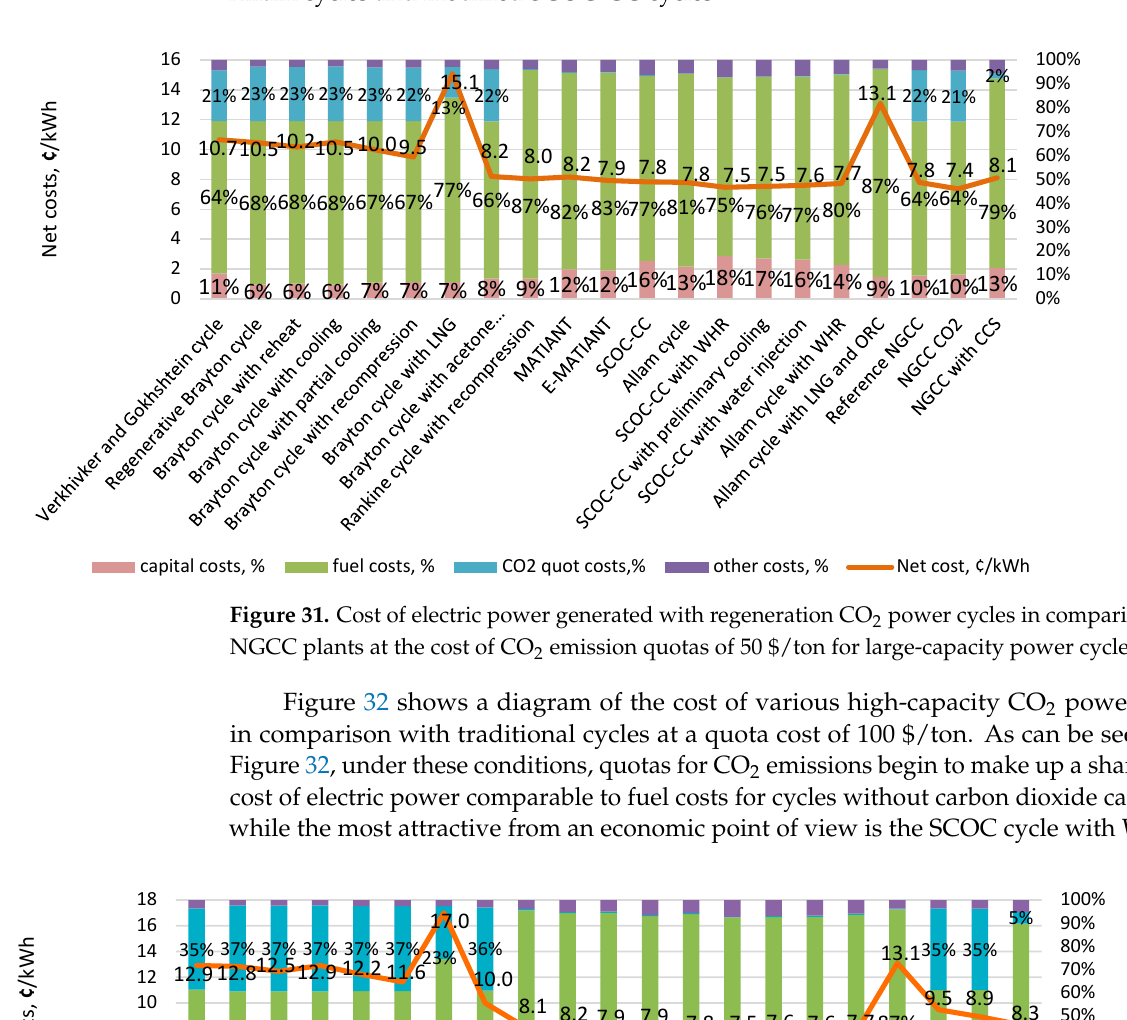
while the most attractive from an economic point of view is the SCOC cycle with WHR.